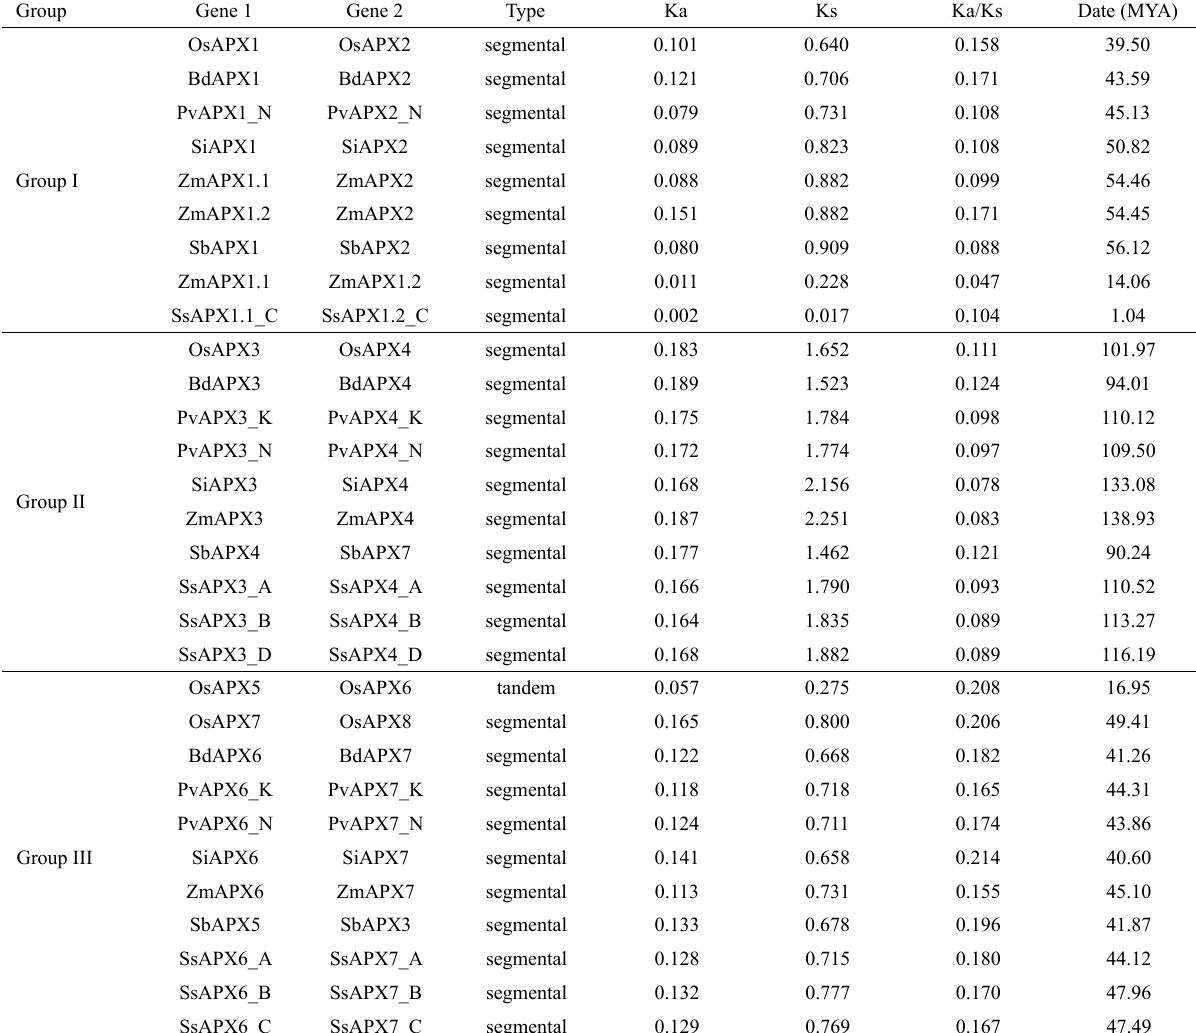
Table 2 – Ka/Ks analysis and divergence time between the duplicated APX gene pairs in Oryza sativa , Brachypodium distachyion , Panicum virgatum , Setaria italica , Zea mays , Sorghum bicolor and Saccharum spontaneum . Ka. Non-synonymous substitution rate; Ks. Synonymous substitution rate; MYA. Million years